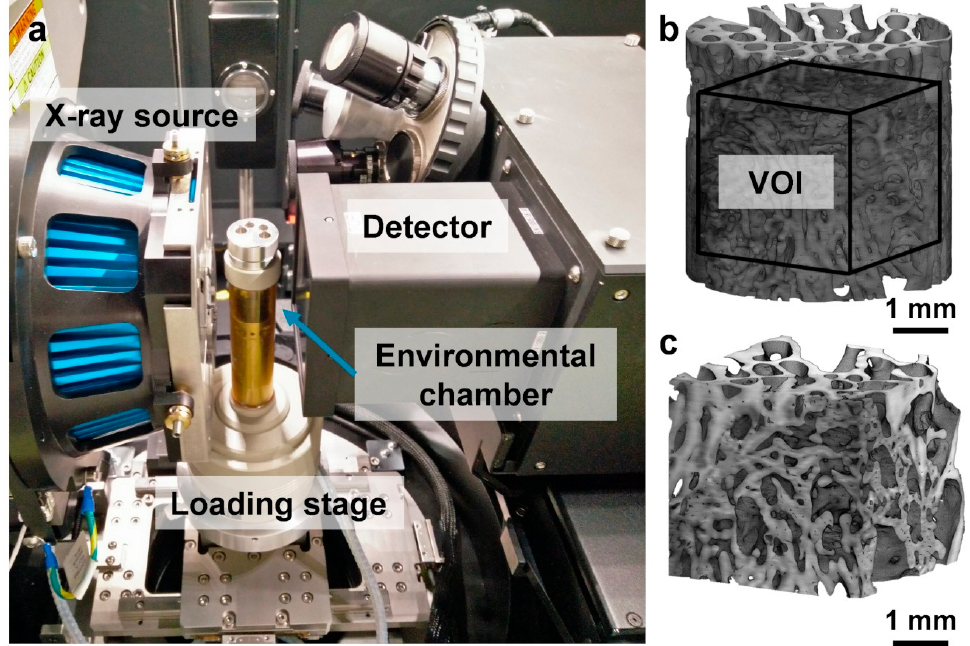
Figure 1. ( a ) Experimental setup for in situ micro-computed tomography (microCT) experiment